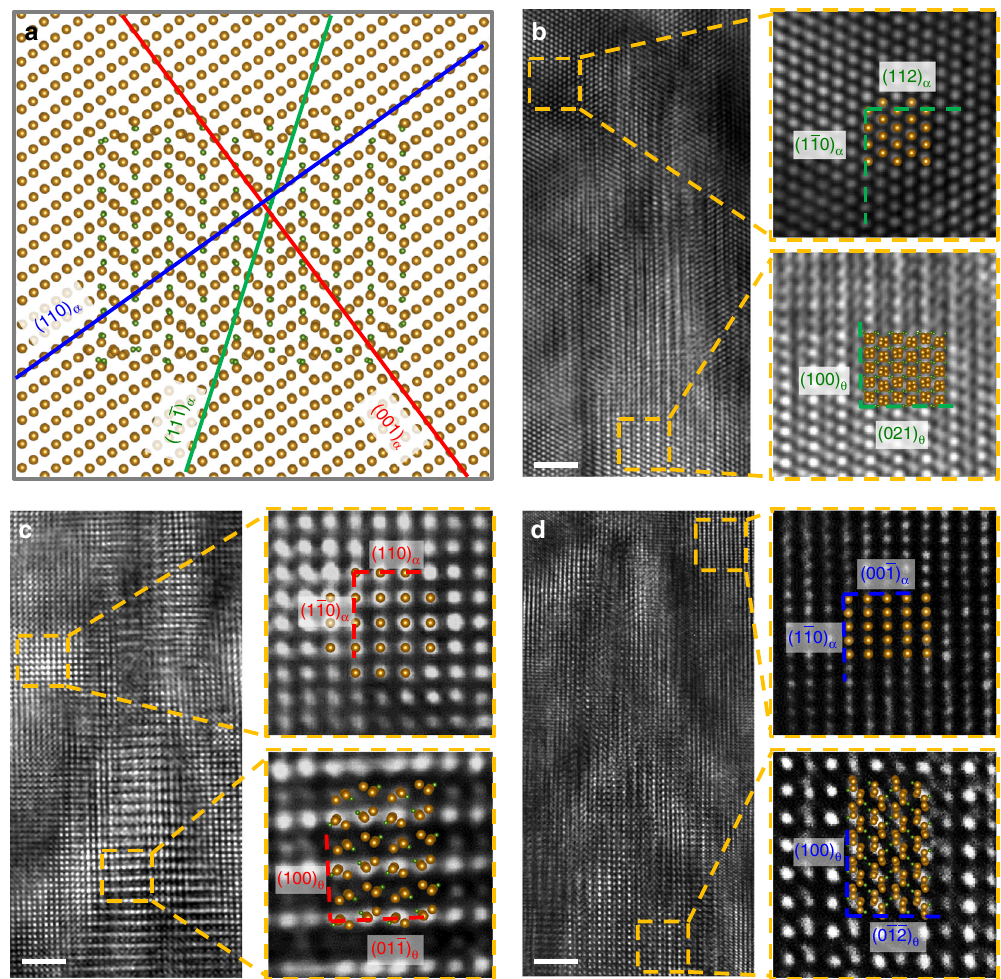
Fig. 5 Comparison of atomic structures from theory and experiment. a The sectioning planes of ð 11 (cid:1) 1 Þ α , (001) α and (110) α (as indicated by green, red, and blue lines, respectively) projected on ð 1 (cid:1) 10 Þ α . b – d The atomic structures of the ð 11 (cid:1) 1 Þ α , (001) α , and (110) α cross-sections in the superlattice plotted on top of the experimental HRTEM images in Fig. 1(c – e). Scale bar, 2